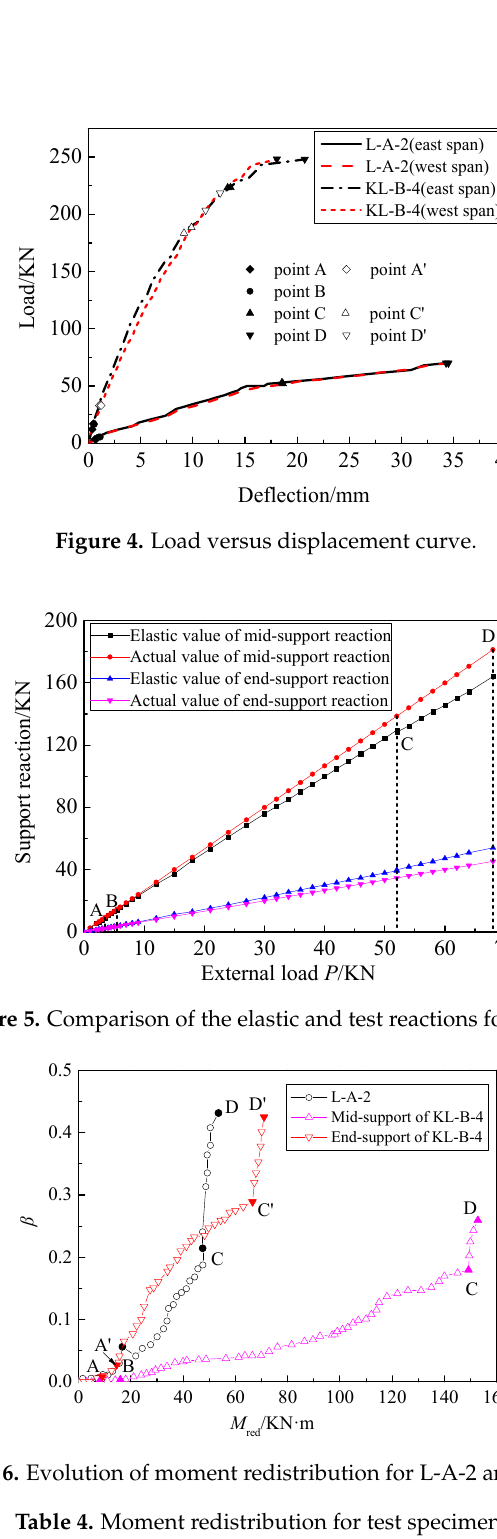
Table 4. Moment redistribution for test specimens.